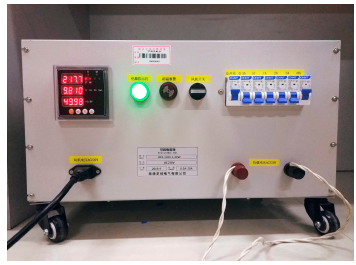
Figure 26. Adjustable resistance load box.